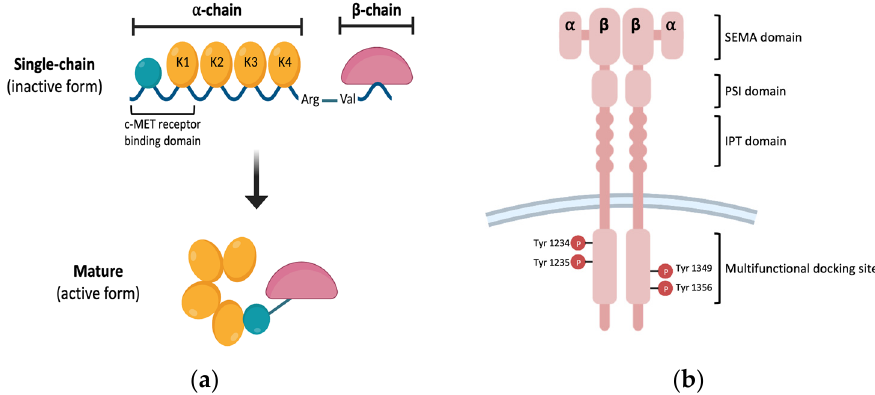
Figure 1. Schematic structure of HGF and MET. ( a ) HGF structure. HGF is a heterodimer that consists of alpha- and beta-chains linked via disulfide bonds. An alpha chain is composed of N-terminal hairpin domain and four kringle domains, and a beta chain is composed of serine-protease homology domain. Alpha- and beta-chains are connected by disulfide bonds and are cleaved by serum-derived proteases to convert to the active from. ( b ) MET structure. c-MET is a heterodimer linked by an extracellular alpha-chain and a transmembrane beta-chain. The beta-chain consists of a SEMA domain, PSI domain, IPT domain, multifunctional docking site, and C-terminal tail region. The multifunctional docking site has several tyrosine kinase domains.